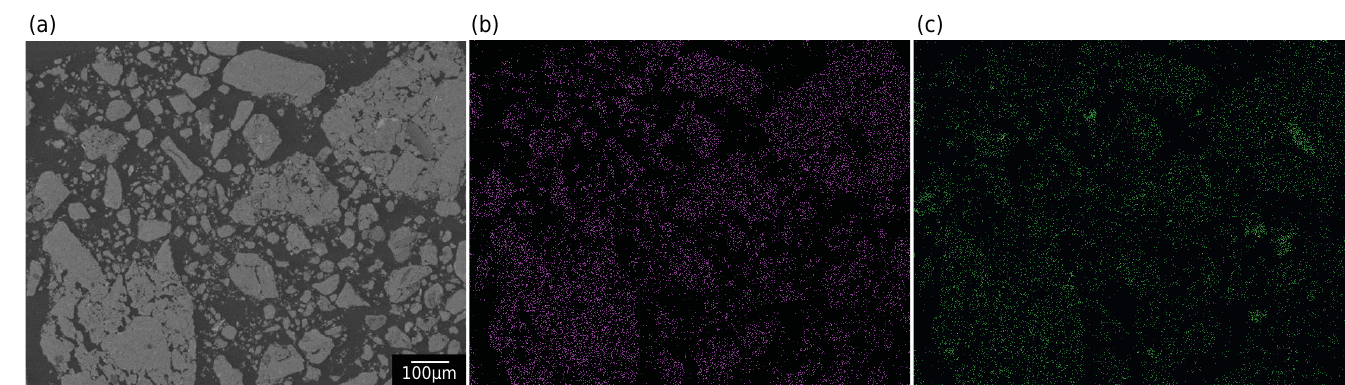
Figure 1. Scanning electron microscopy images of minerals synthesized from treatment 1 (Table 1) using sulfate salts. (a) backscattered electron image, showing aggregates of goethite (light gray) with a small number of Al-rich aggregates (dark gray), interpreted as bayerite [Al(OH) 3 ]; (b) Fe elemental map; and (c) Al elemental map of the backscattered image shown in (a). Note the homogeneous distribution of Al across the goethite